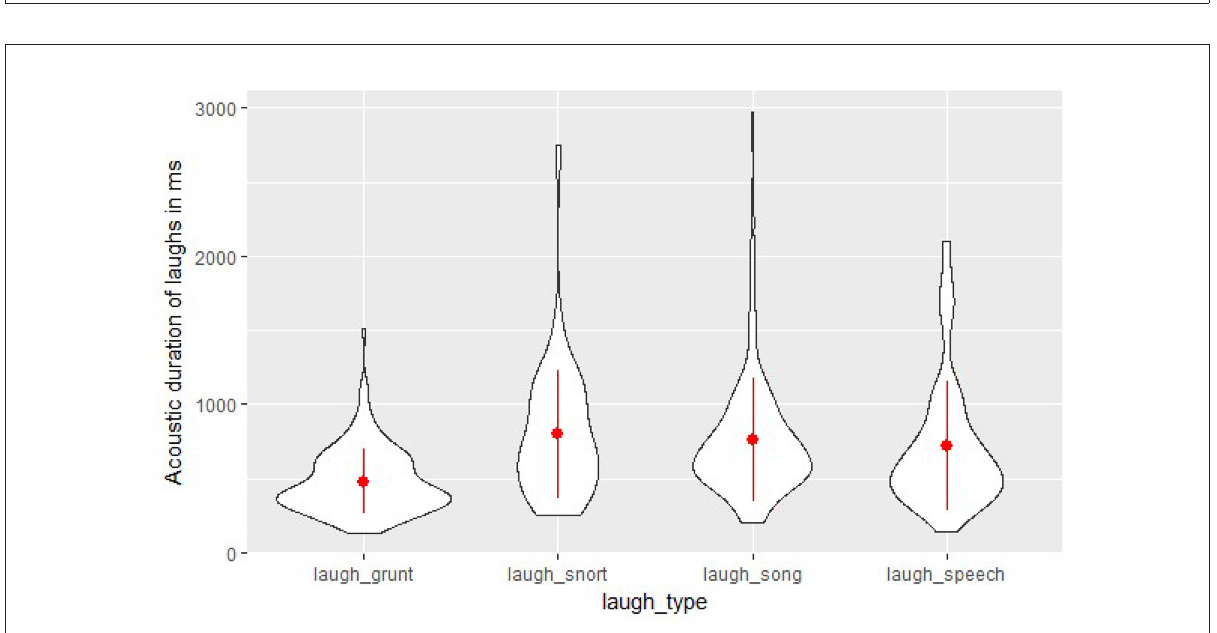
Respiratory properties of shared